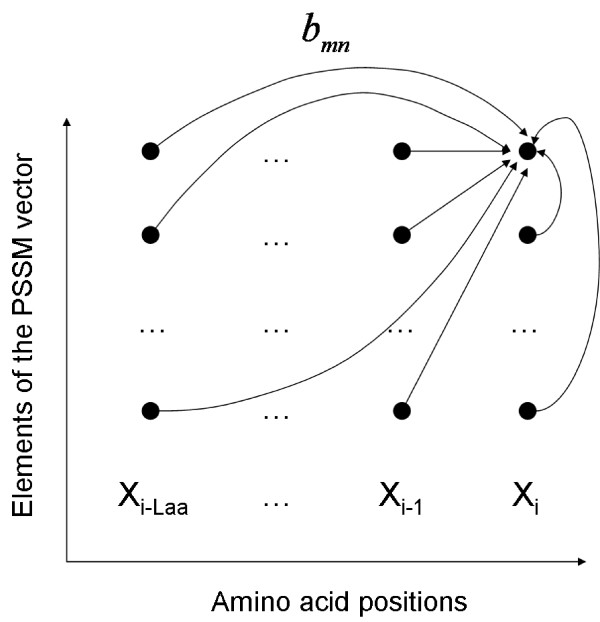
Schematic of the dlink structure, used to represent correlations in the DBN. Each node represent a PSSM element and edges represent the dlink coefficients of the DBN. The rightmost column corresponds to the ith vector of the PSSM Xi (i.e., the vector for the ith position along the amino acid sequence). The remaining columns represent the columns of the PSSM that come before the ith position if we traverse the sequence from the N-terminal to the C-terminal of the protein. Rows represent the 20 amino acids in the PSSM. For simplicity only edges for the child node xi(1) is shown, which is the first element of the observation vector at the ith position. The child nodes are in the rightmost column and the parent nodes are in positions i - LAA, ..., i.